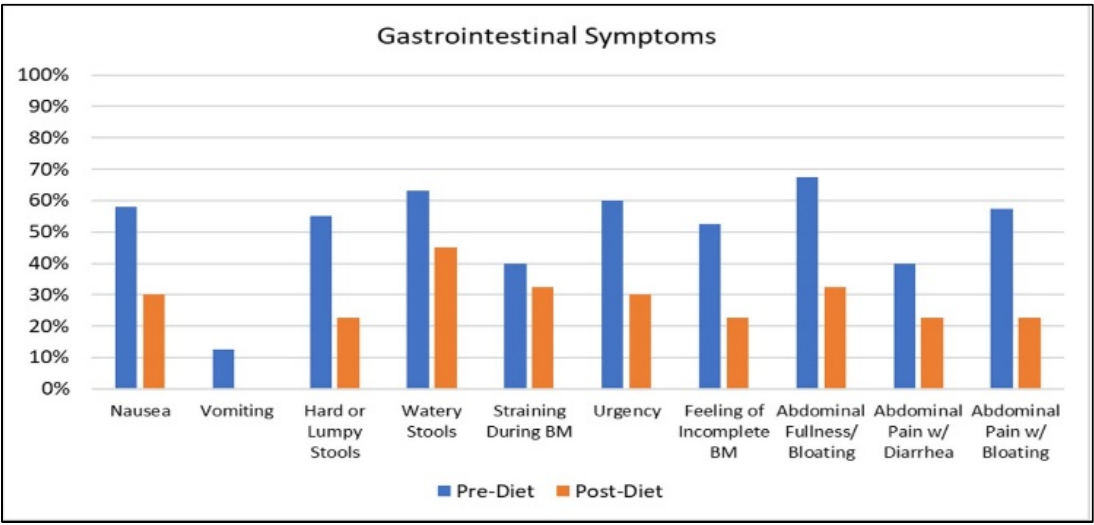
Figure 2. Percentage of veterans reporting gastrointestinal symptoms pre–post diet.